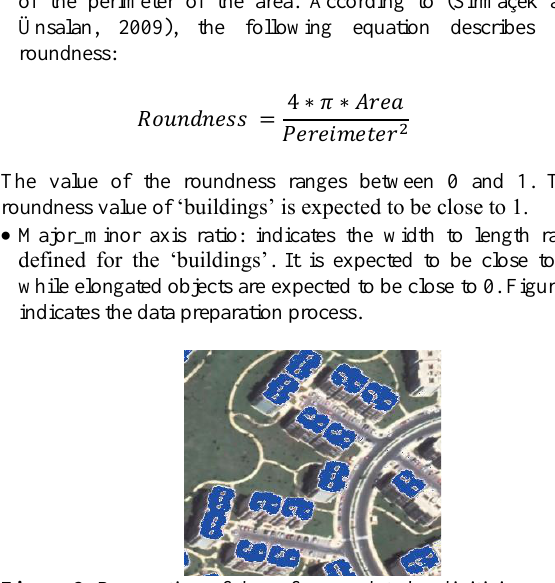
Figure 2 . Preparation of the reference data by digitizing using ImageJ